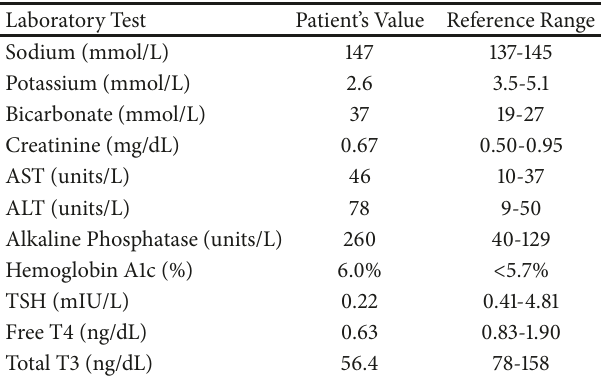
Table 1: Laboratory values on